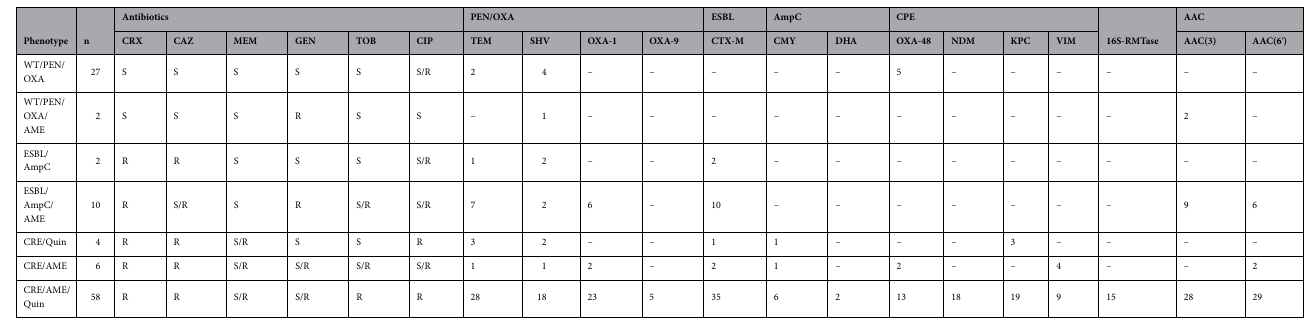
Table 4. One hundred and nine K. pneumoniae isolates classified according to their beta-lactamase phenotype including the detected resistance mechanisms against beta-lactams and aminoglycosides by LC–MS/MS. Isolates were classified based on their susceptibility (S) or resistance (R) to ceftriaxone (CRX), ceftazidime (CAZ), meropenem (MEM), gentamicin (GEN), tobramycin (TOB) and ciprofloxacin